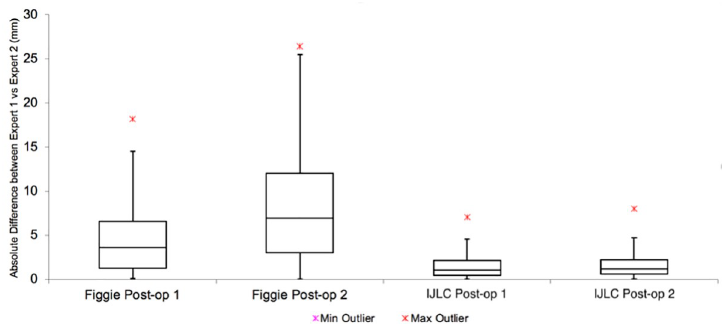
Fig 4. Boxplot demonstrating the differences between measurements performed by senior orthopaedic surgeon 1 and 2 on post-operative radiographs.